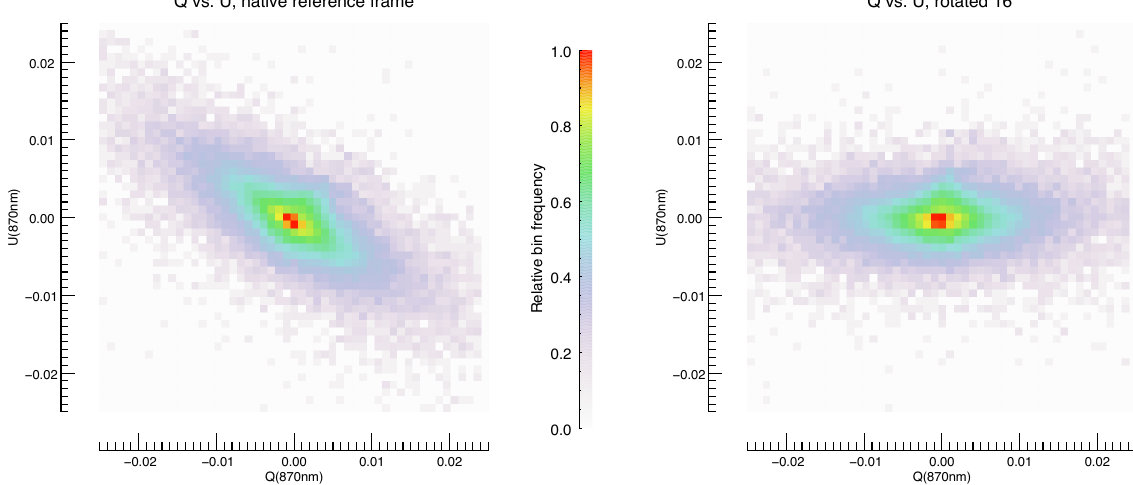
Figure 10. Two-dimensional histograms of Q vs. U for the AERONET Cimel instrument operating at the CESAR site from 9 June 2010 to 15 March 2013. The histogram on the left is for Q and U defined assuming the instrument linear polarizers are aligned with the solar principal plane. Scattering theory for randomly oriented particles indicates that U should be minimized and Q maximized when they are defined with respect to the solar principal plane. Since this is not the case, we found that only by rotating the assumed polarizing filter orientation by 16 ◦ could we pinpoint the appropriate distribution of Q and U , shown on the